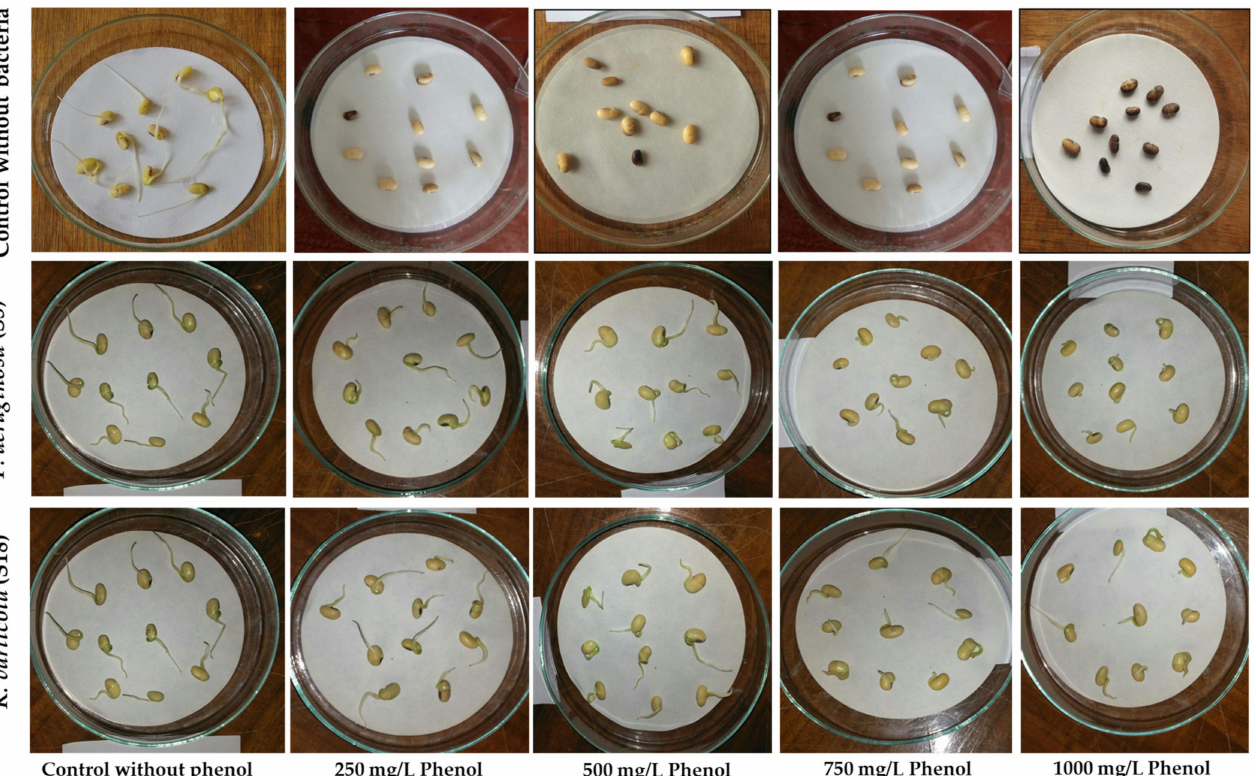
Figure 7. Effect of Pseudomonas aeruginosa (S3) and Klebsiella variicola (S18) on soybean seed germina- tion after bioremediation and detoxification of water contaminated with different concentrations of phenol (0.0, 250, 500, 750, and 1000